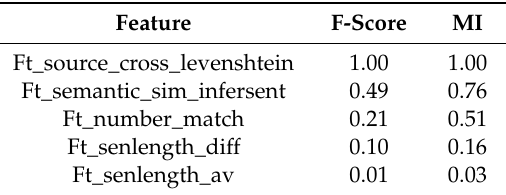
Table 5. Normalized F-score and